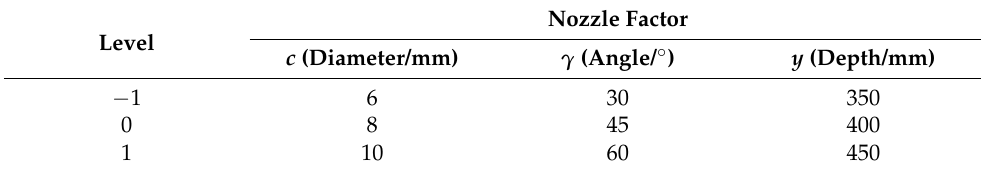
Table 7. Table of levels and factors for fluid–solid coupling test.